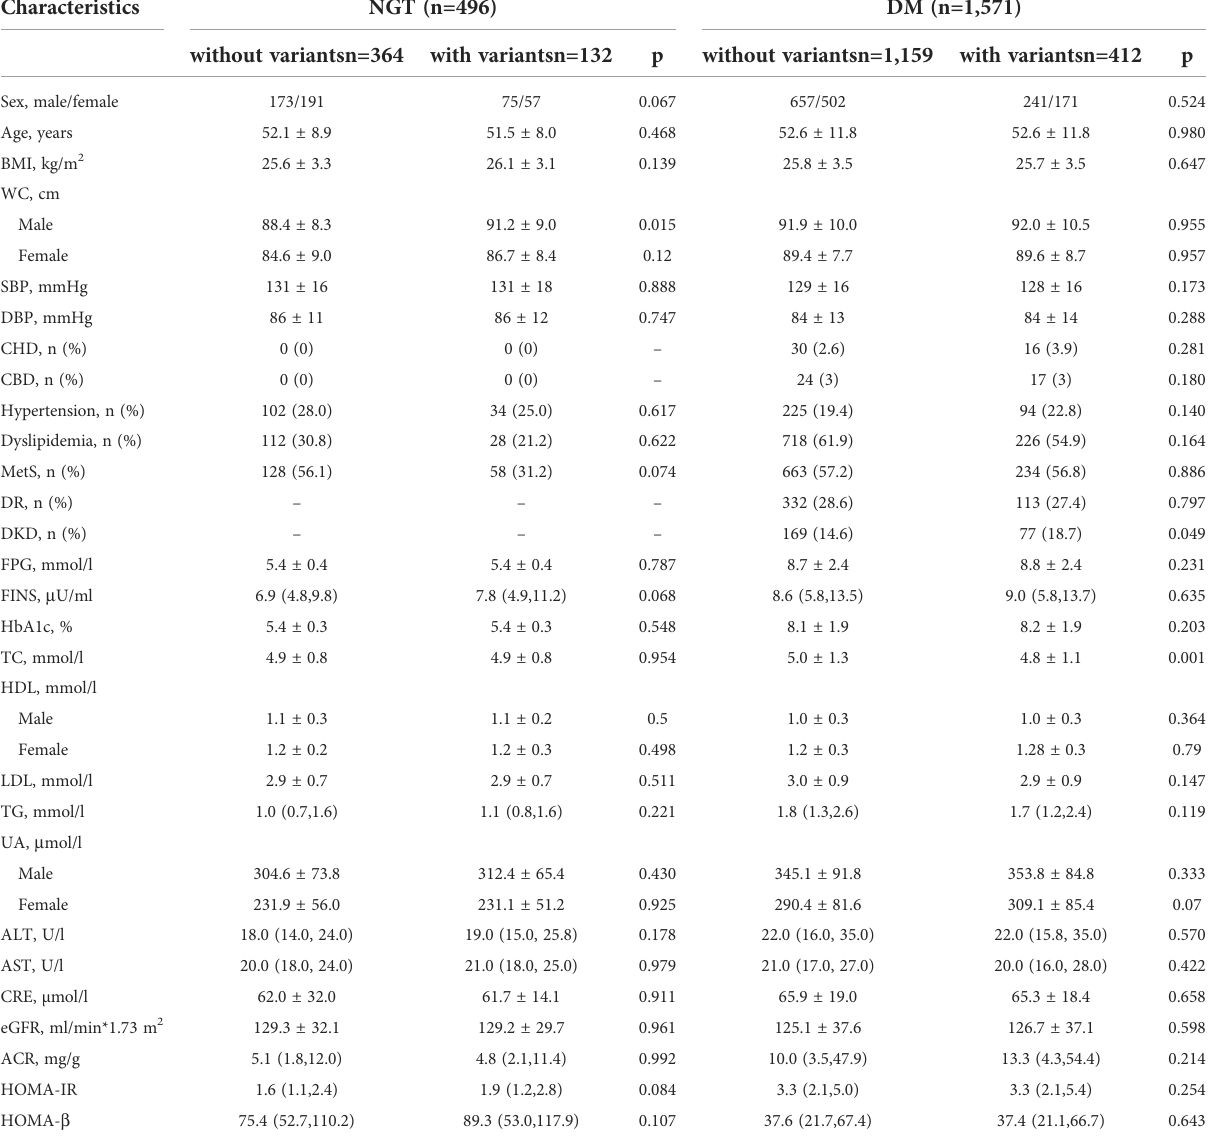
TABLE 8 The comparison of the subjects without the 20 variants and with the 20 variants in normal glucose tolerance and diabetes mellitus groups from cohort 3.